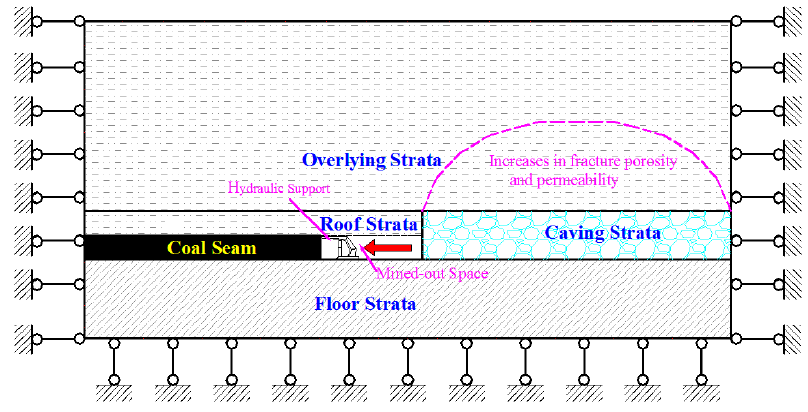
Figure 1. Schematic cross-sectional view illustrating the longwall mining system along with the direction of the advancing face.